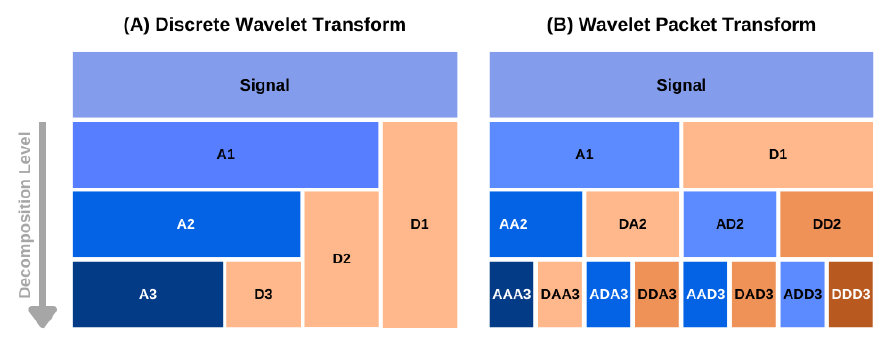
Figure A1. A schematic diagram of data decomposition in discrete ( A ) and packet wavelet transform ( B ) methods. The approximation and detail components at level k are denoted as A k and D k in ( A ). In the case of the wavelet packet transform, the approximation and detail components at a decomposition level are denoted by the component name of the previous level followed by A k or D k , respectively